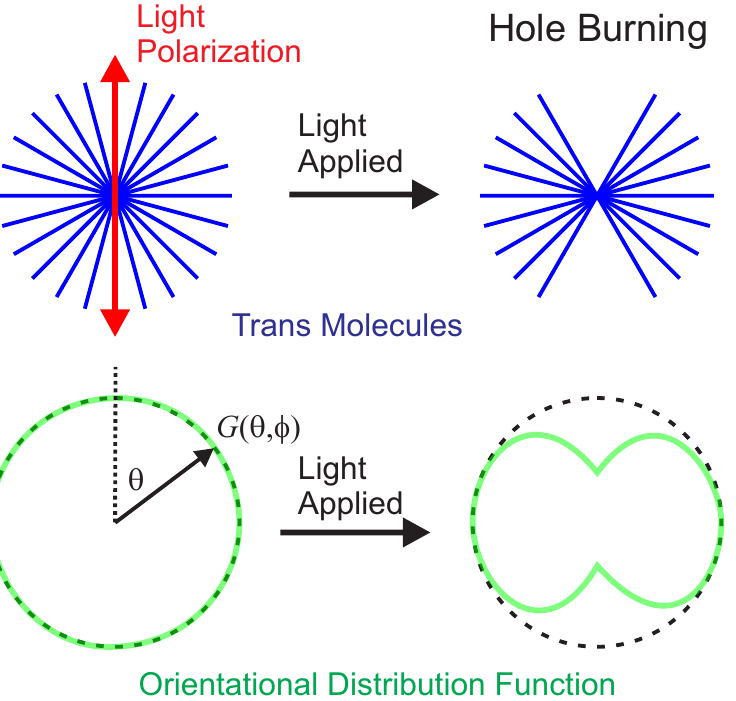
Figure 1. The lines in the upper plot represent an isotropic distribution of trans molecules, which are depleted along the pump light’s polarization (vertical) as they are converted to cis molecules. The bottom plots show the corresponding orientational distribution